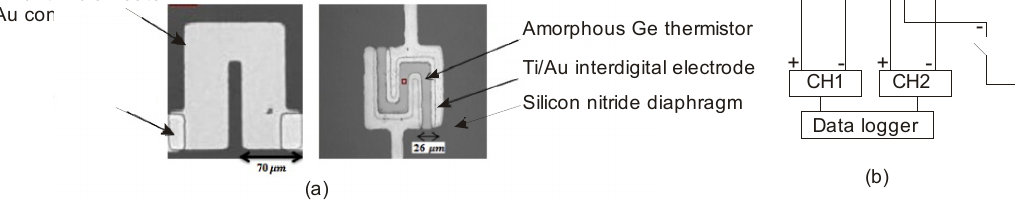
Figure 8. ( a ) Microscopic images of the heater and thermistor reported by Yarali et al. [90] (reprinted with permission from Sens. Actuat. Phys. A ); ( b ) a prototype anemometer for industrial bread baking applications.